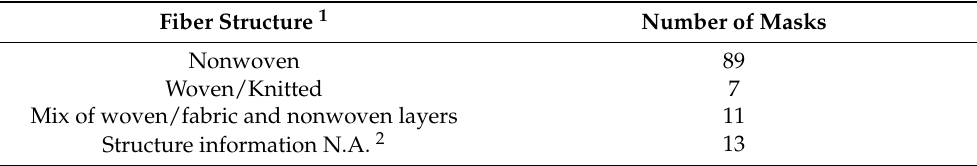
Table 3. Number of tested masks broken down according to the fiber structure.